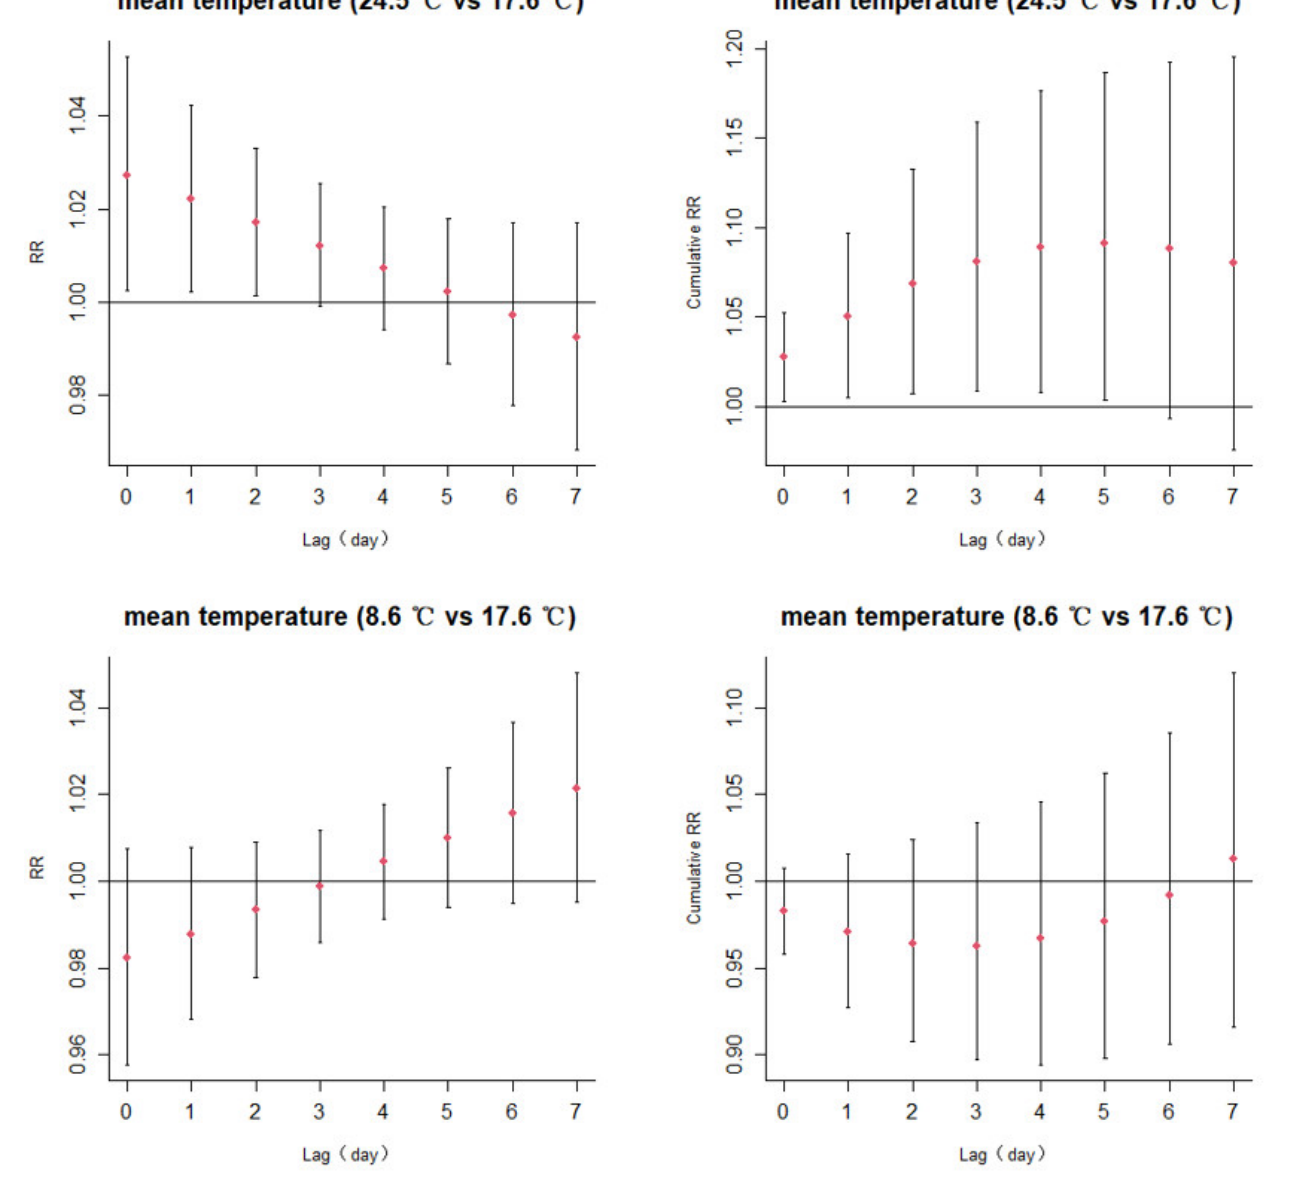
Figure 3. Lag-specific relative risks (95%CI) and cumulative risks (95%CI) in outpatient visits for herpes zoster with high (75th percentile 24.5 °C) and low (25th percentile 8.6 °C) levels of the mean temperature in the model.